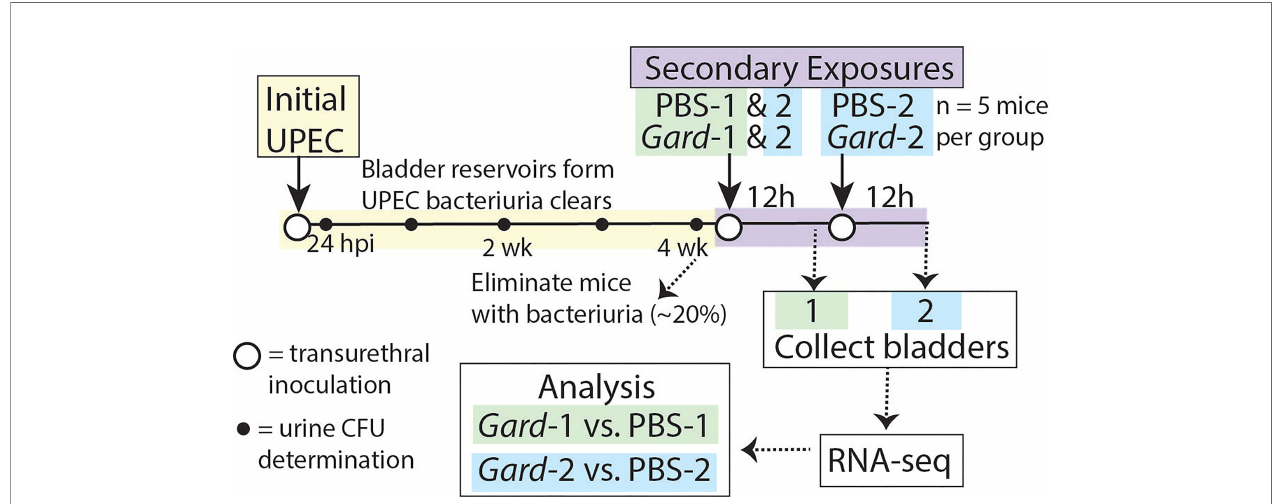
FIGURE 1 | Mouse model schematic for RNA-seq experiments. The time line of the model depicts the ‘ Initial UPEC ’ reservoir formation phase in yellow and the ‘ Secondary Exposure ’ phase in purple. Female C57BL/6 mice were inoculated transurethrally (open circles) with UPEC and bacteriuria was monitored weekly (closed circles). Mice that cleared UPEC bacteriuria were inoculated transurethrally with either PBS as a control or Gardnerella . Twelve hours later Exposure Group 1 was sacri fi ced while Exposure Group 2 received an additional transurethral inoculation and was sacri fi ced twelve hours (h) later. For the bladder titer experiments described in Figures 4 , 5 the second exposure occurred one week later instead of 12 h later and bladders were collected 72 h after the second